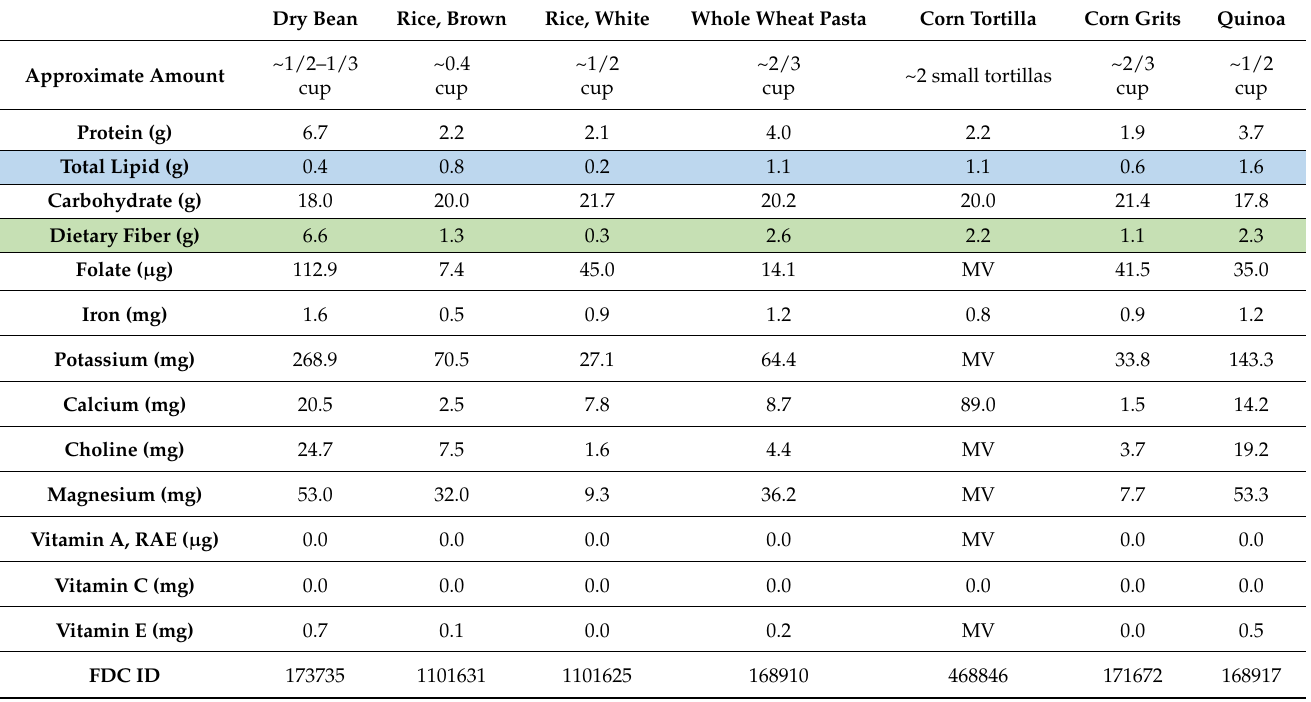
Table 4. Nutritional analysis of 100 kilocalorie portions of dry bean versus common